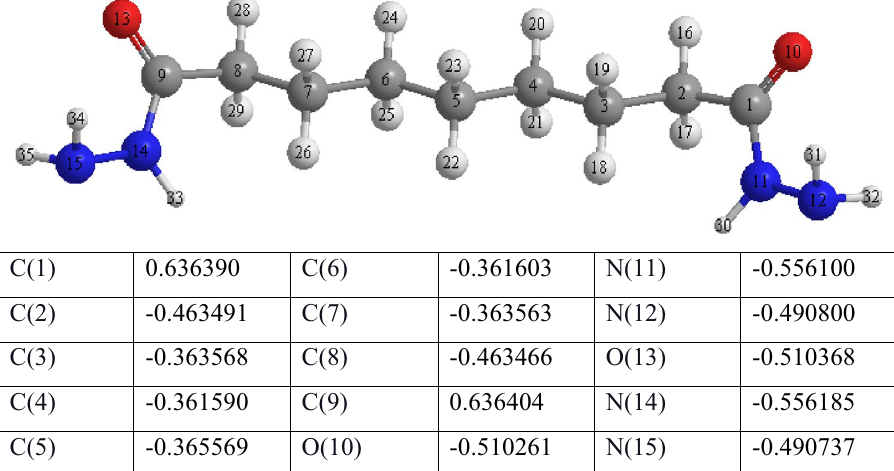
Table 10. Calculated Mulliken charges of the inhibitor molecule